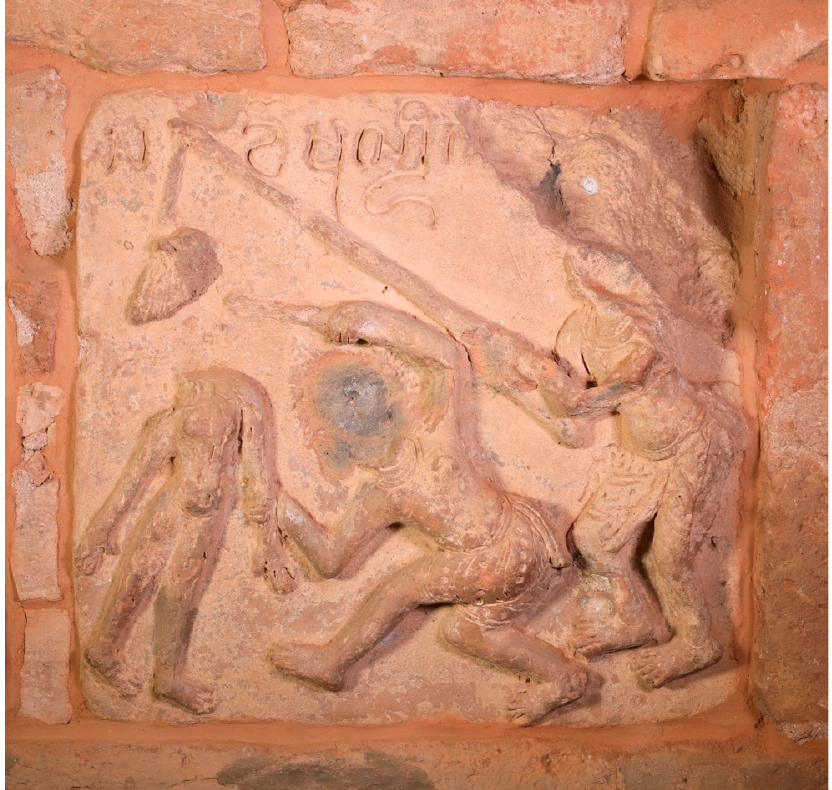
Figure 18. Pagan, Hpetleik stupa, 11th century. Sankhamundika Hell.